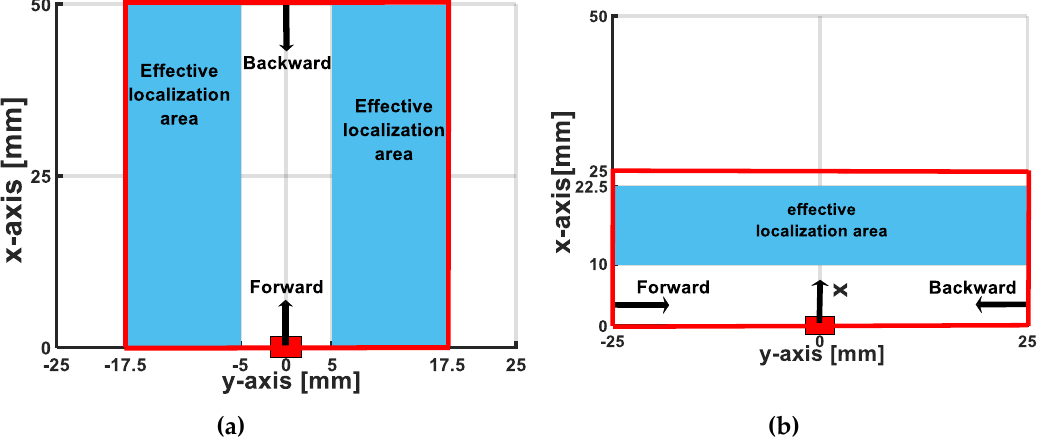
Figure 23. Schematic illustration of detectable area of tactile sensing system. In detectable area (inside red lines), sensing system can detect sliding direction and estimate velocity where maximum errors are less than 8%, and in effective localization area (blue areas), distance from accelerometer to sliding objects can be estimated where maximum errors are less than 15%. ( a ) X-sliding case. ( b ) Y-sliding case.